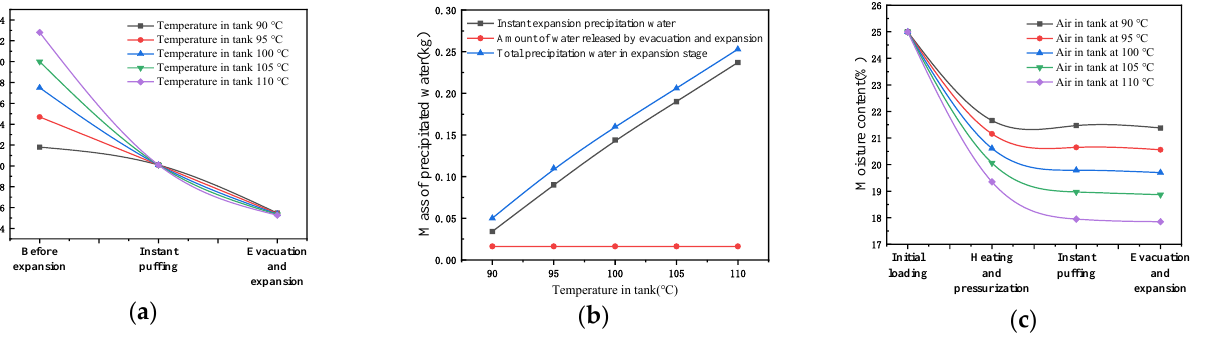
Figure 5. Effect of temperature in tank on mass transfer in expansion stage. ( a ) Effect of the temperature in the pressure section on the drying temperature of expanded fruit. ( b ) Influence of temperature in pressurized section on water precipitation in expanded section. ( c ) Effect of temperature in pressurized tank on moisture content of dried fruit.